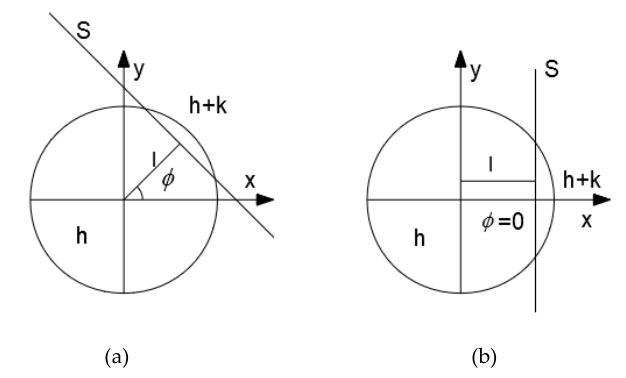
( c ) Figure 2. Processed image: ( a ) Original image; ( b ) Grayscale image; ( c ) Edges in the image. When the camera is not very close to the object or the camera does not have high resolution, the accuracy obtained is usually not adequate. There are two approaches to enhance it. One is to use a higher resolution camera. The other way is to use the sub-pixel technology to improve accuracy of the image analysis. Some researchers have incorporated the subpixel technique to the conventional template matching methodology, mostly using interpolation. In this paper, edge detection method is combined with the subpixel technique to achieve better accuracy. After the displacement at an integer-pixel level is obtained, the subpixel technique based on Zernike moment method could be used to obtain subpixel level displacements and achieve more accurate results. At the same time, to convert the displacement in pixel to the real physical distance, a relationship between the pixel and physical coordinates needs to be established. 3. Principles of Zernike Moment-Based Subpixel Edge Detection Photo images are very sensitive to noises such as change in brightness and the vibration of the camera. Zernike moment is an integral operator that filters these effects and helps improve the displacement measurement accuracy. Zernike moment has the property of rotation invariance [20,21], which can be written as,